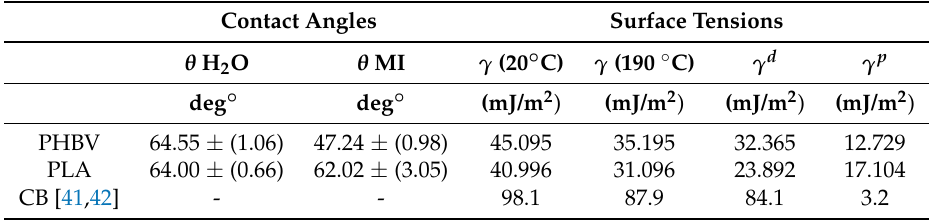
Table 3. Contact angles and surface tensions using the Owens-Wendt model.